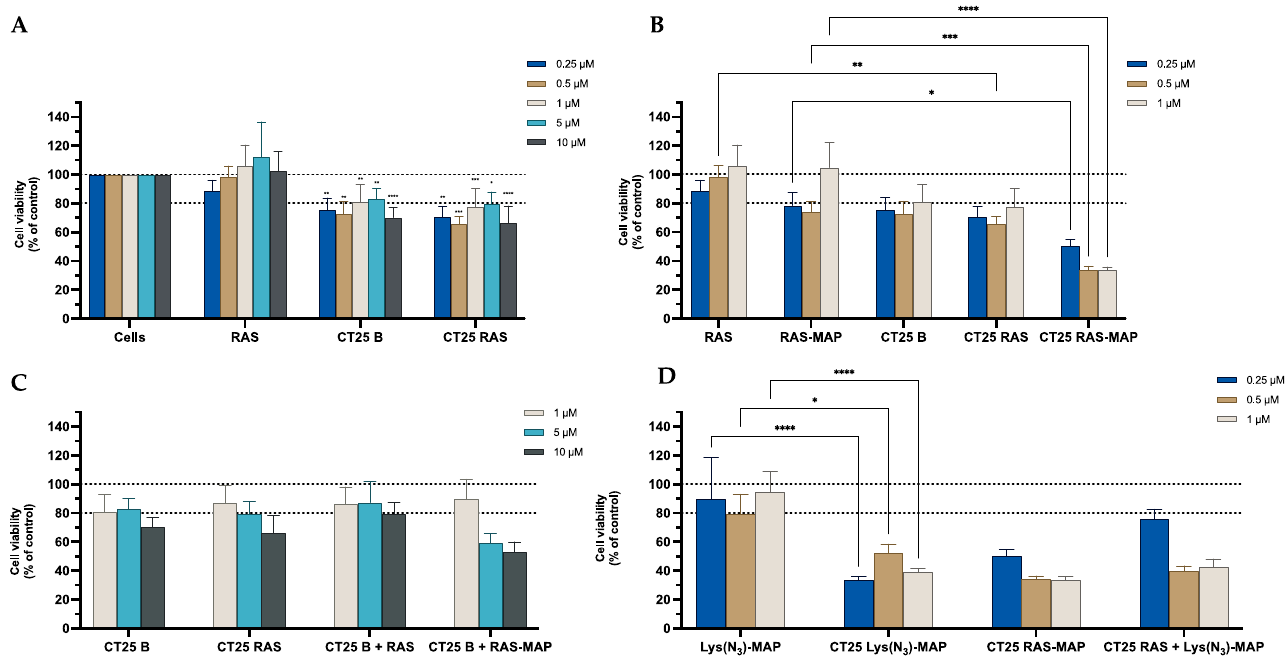
Figure 13. Relative cell viability of SH-SY5Y cell line measured by the MTT reduction after 24 h incubation. ( A ) Represents NLC safety test with the treatment of free RAS, blank CT25 and RAS-loaded CT25 (0.25–10 µ M). ( B ) Represents differences in the cell viability of treatment with free RAS, RAS-MAP, blank CT25, RAS-loaded CT25, MAP, RAS-MAP-loaded CT25 (0.25–10 µ M). ( C ) Represents co-administration of RAS and RAS-MAP with blank CT25 (1–10 µ M). ( D ) Represents the data obtained from the encapsulation of Lys(N 3 )-MAP and co-encapsulation of RAS and Lys(N 3 )-MAP in the NLC compared with peptide conjugate. Results are expressed as means ± SD (n = 4). Statistical analysis between the groups was performed using two-way ANOVA with Tukey’s multiple comparisons test (* p < 0.05; ** p < 0.01; *** p < 0.001; **** p < 0.0001).